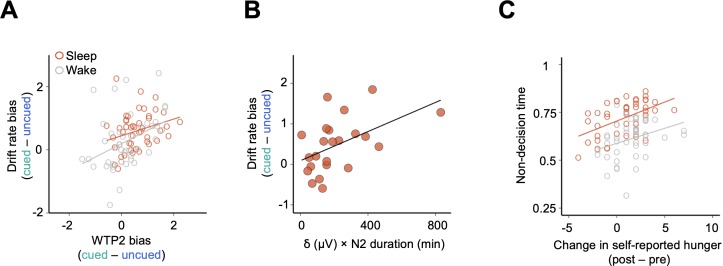
Across-subject differences in LBA estimates.(A) Drift rate biases can be predicted by biases in WTP2 across all subjects (r = 0.37, p = 0.001), with no significant difference in the correlation coefficient across cohorts (sleep: r = 0.28; wake: r = 0.35; F1,88 = 0.50, p = 0.480). (B) Among sleep group participants with EEG recordings, the estimated drift rate bias was scaled with the amount of memory reactivation occurring during N2, as indexed by the duration of N2 multiplied by the degree of increase in delta band power evoked by verbal cues presented during N2 (r = 0.499, p = 0.015). (C) In both sleep and wake group, non-decision time estimates are correlated with the change of self-reported hunger before and after the stimulation session (r = 0.27, p = 0.009), with no significant difference in the correlation coefficient across cohorts (sleep: 0.51; wake: r = 032; F1,88 = 0.23, p = 0.633). Each circle indicates a subject.